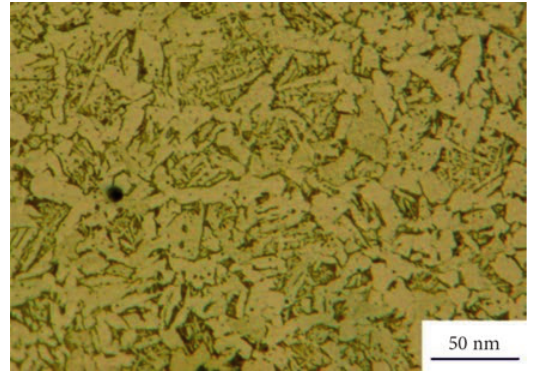
Fig. 9. Microstructure of welded metal (VSR during